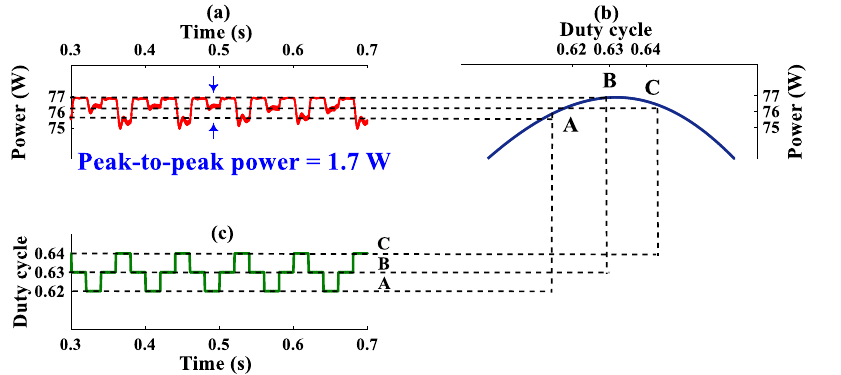
Figure 11. Steady-state oscillation around the MPP using the CSL algorithm with the three-level operation: ( a ) power versus time, ( b ) PV power versus duty cycle, and ( c ) duty cycle versus time.